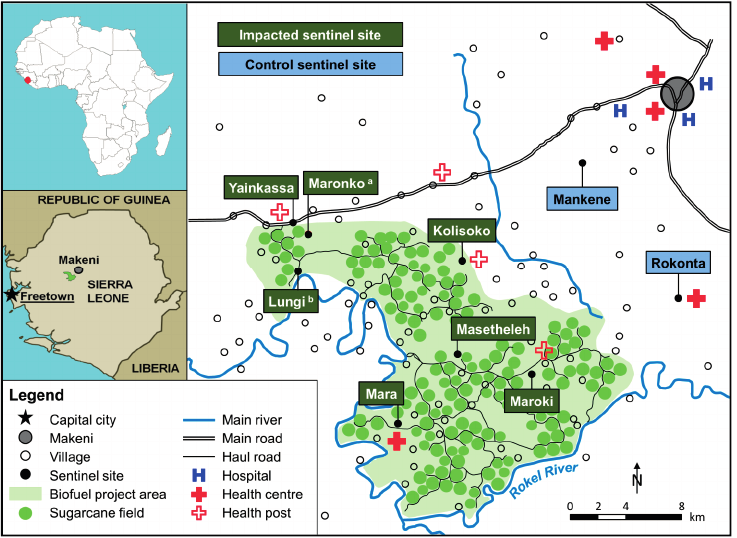
Figure 2. Sentinel sites of the follow-up health survey in the ABSL project study area in Northern Sierra Leone,